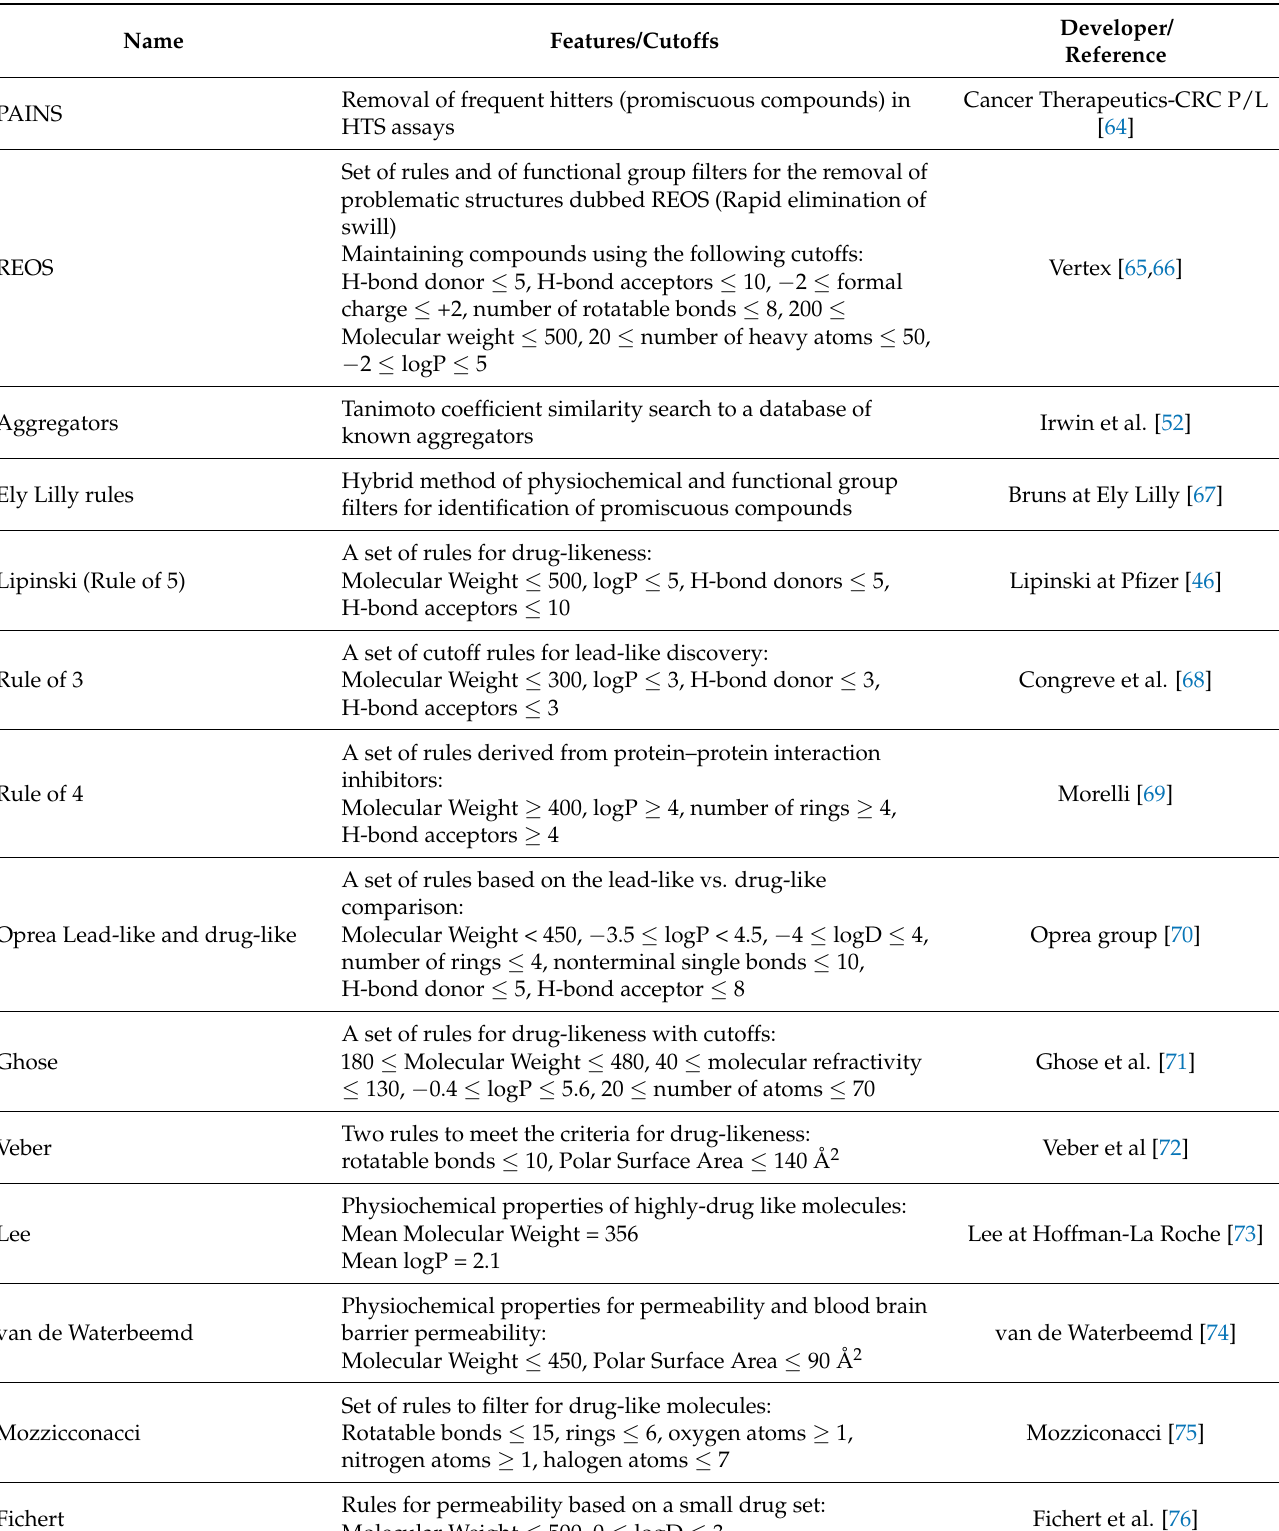
Table 1. Essential filters for efficient library design in medicinal